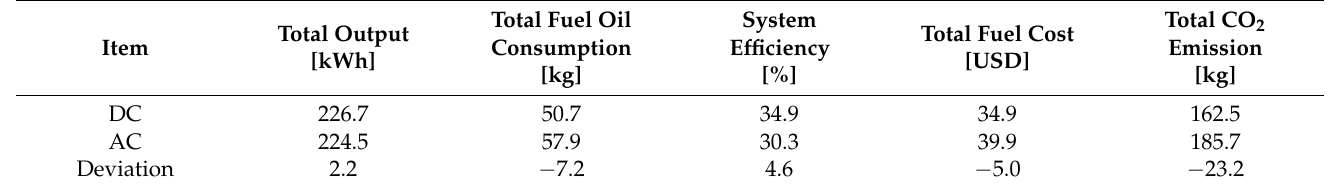
Table 8. The comparison results of the total output, total fuel oil consumption, system efficiency, total fuel cost, and the total CO 2 emissions for 13K TEU in the AC and DC distribution